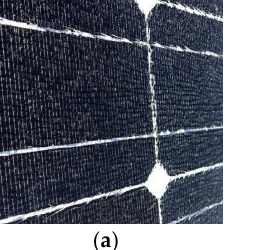
Figure 4. Example showing the impact of hoarfrost and heavy snow on PV modules: ( a ) PV module glass damage observed at Aberdeen site (PV site E) due to a hoarfrost weather event; ( b ) hot spots captured in two different PV modules at Glasgow site (PV site D) after a heavy snow weather event. Table 4. Scotland PV systems’ Degradation Rate Analysis.